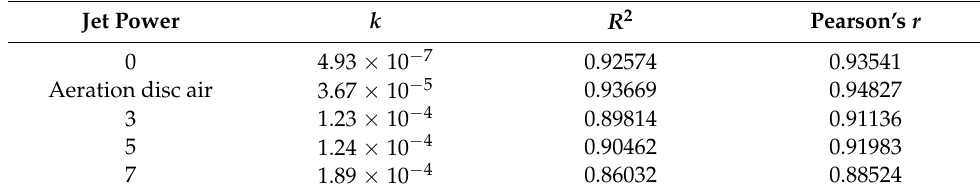
Table 1. Oxidation rate ( k ) for different methods of supplying oxygen.